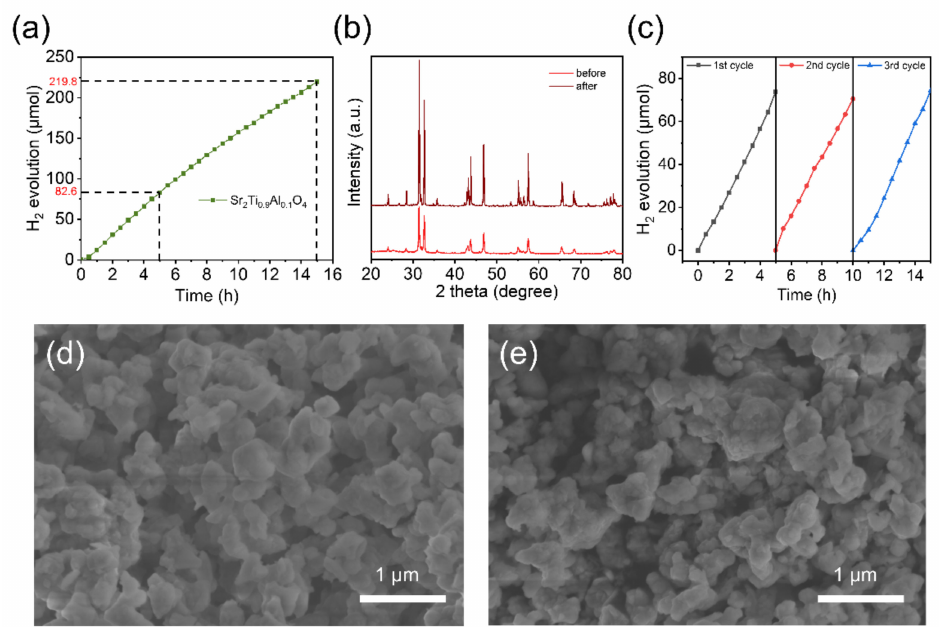
Figure 7. ( a ) H 2 production amounts of Sr 2 Ti 0.9 Al 0.1 O 4 in a continuous test period of 15 h. ( b ) XRD patterns of Sr 2 Ti 0.9 Al 0.1 O 4 before and after the stability test. ( c ) Recycling tests of Sr 2 Ti 0.9 Al 0.1 O 4 for photocatalytic HER. SEM images of Sr 2 Ti 0.9 Al 0.1 O 4 ( d ) before and ( e ) after the stability